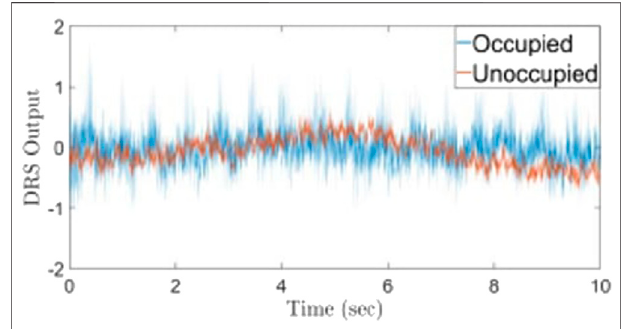
FIGURE 10 | Experimental results of radar-based occupancy state determination where blue line represents occupied and red line denotes unoccupied. From Abedi et al.